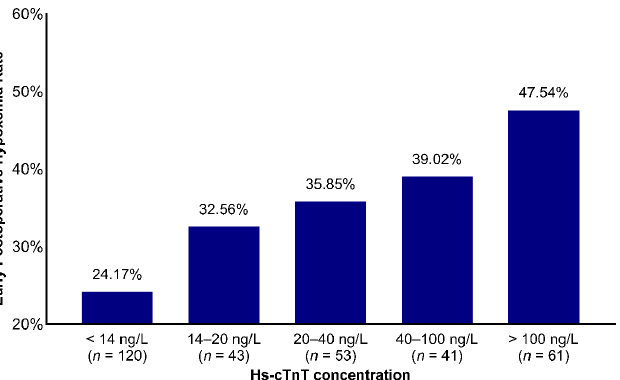
Figure 3. The association of preoperative hs-cTnT levels with EPH after OPCAB demonstrated a stepwise increase in rates with early postoperative hypoxemia (Mantel – Haenszel test for trend p =